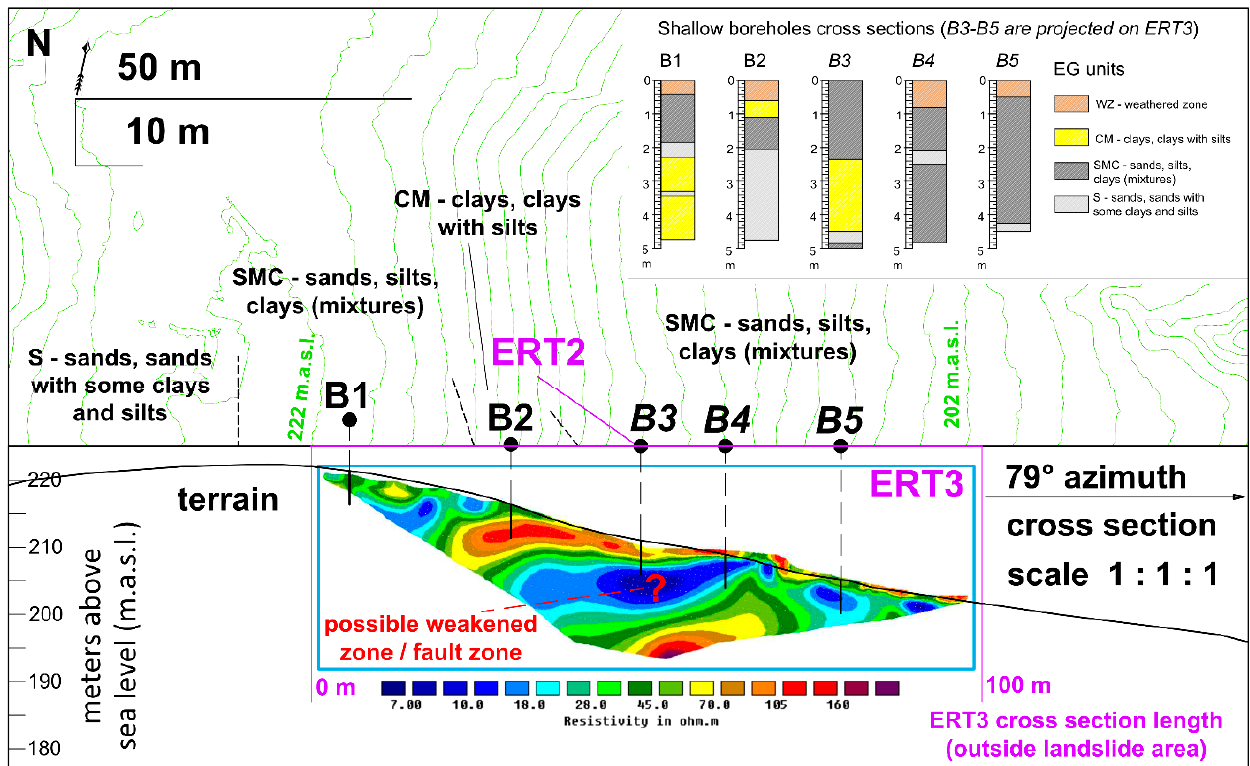
Figure 7. Material properties at ERT3 and B1–B5: outside the landslide area.